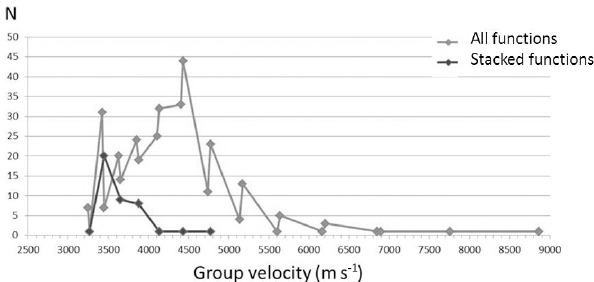
Figure 8. Distribution of the EGF by group velocities for frequen- cies of